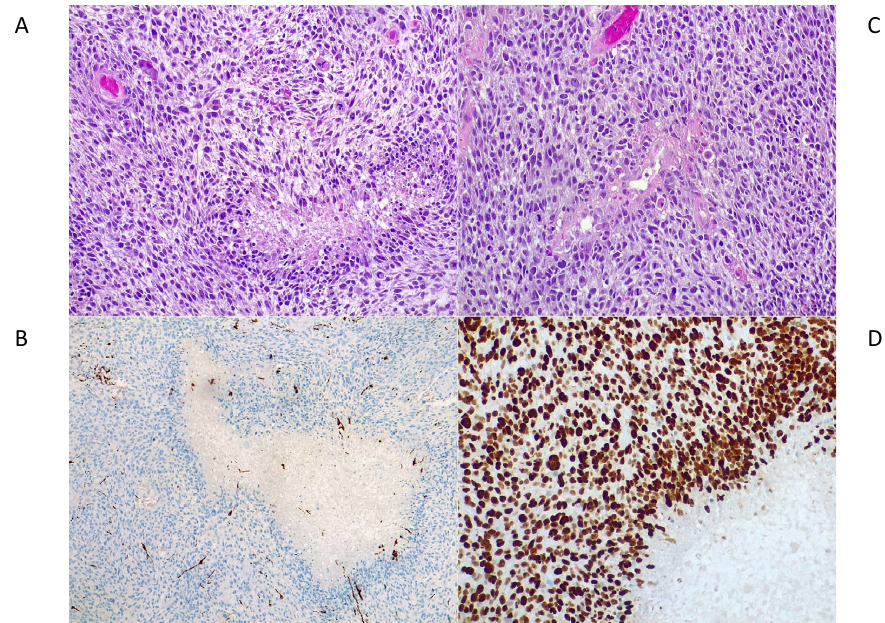
Figure 3. Histopathological features of the tumor. ( A ) Epithelioid to spindled cells, high mitotic activity, and a focus of palisading necrosis (hematoxylin-eosin staining, original magnification 200 × ). In pink the cytoplasms of cells and in violet the nuclei of cells ( B ) Vascular proliferation and perivascular pseudorosettes (hematoxylin-eosin staining, original magnification 200 × ) In pink the cytoplasms of cells and in violet the nuclei of cells. ( C ) SMA negativity (immunoperoxidase staining, original magnification 200 × ). ( D ) High proliferative index of a representative tumoral area, with Ki67 value near 70% (immunoperoxidase staining, original magnification 400 × . In brown the positivity to ki67